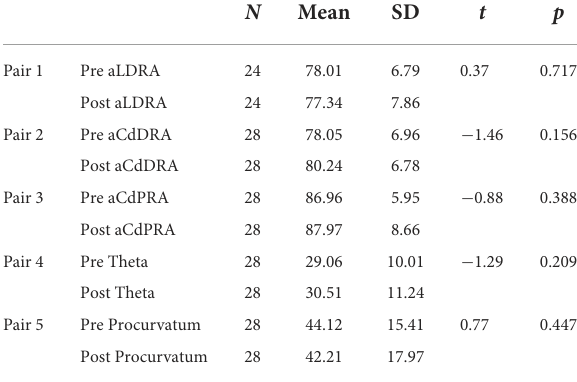
TABLE 4 Paired samples t -test results including the number of limbs evaluated (N), the arithmetic mean, standard deviation (SD), the t -value ( t ), and p -value ( p